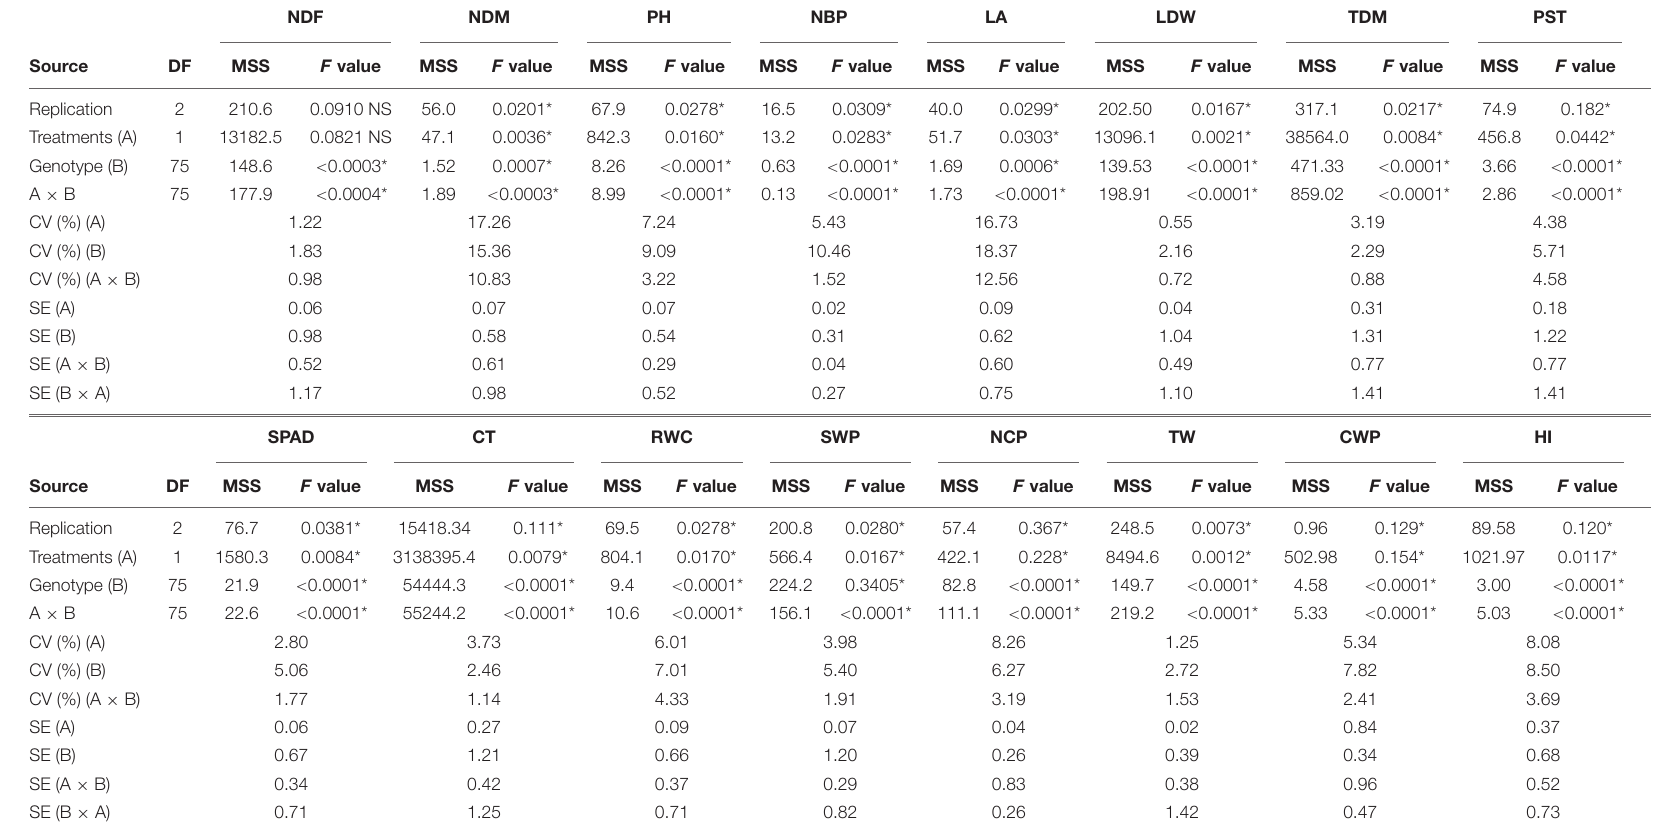
TABLE 1 | Analysis of variance (ANOVA) of 76 sesame genotypes along with checks during the year